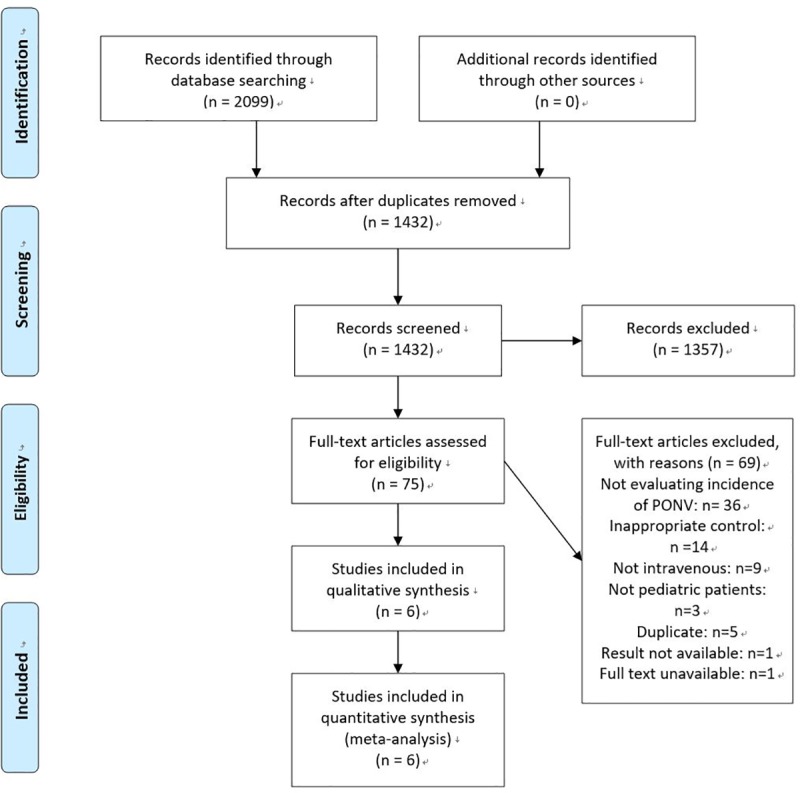
PRISMA flow diagram.